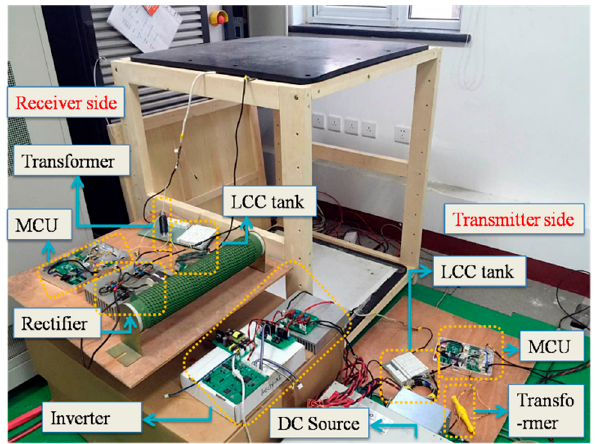
Figure 12. Photograph of our system.